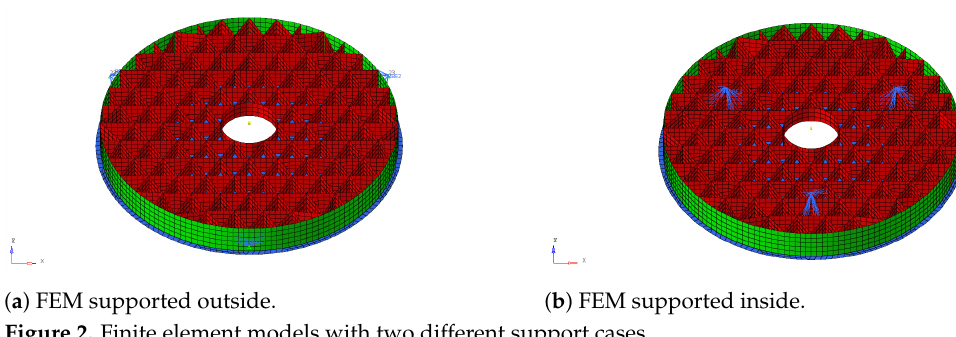
Figure 2. Finite element models with two different support